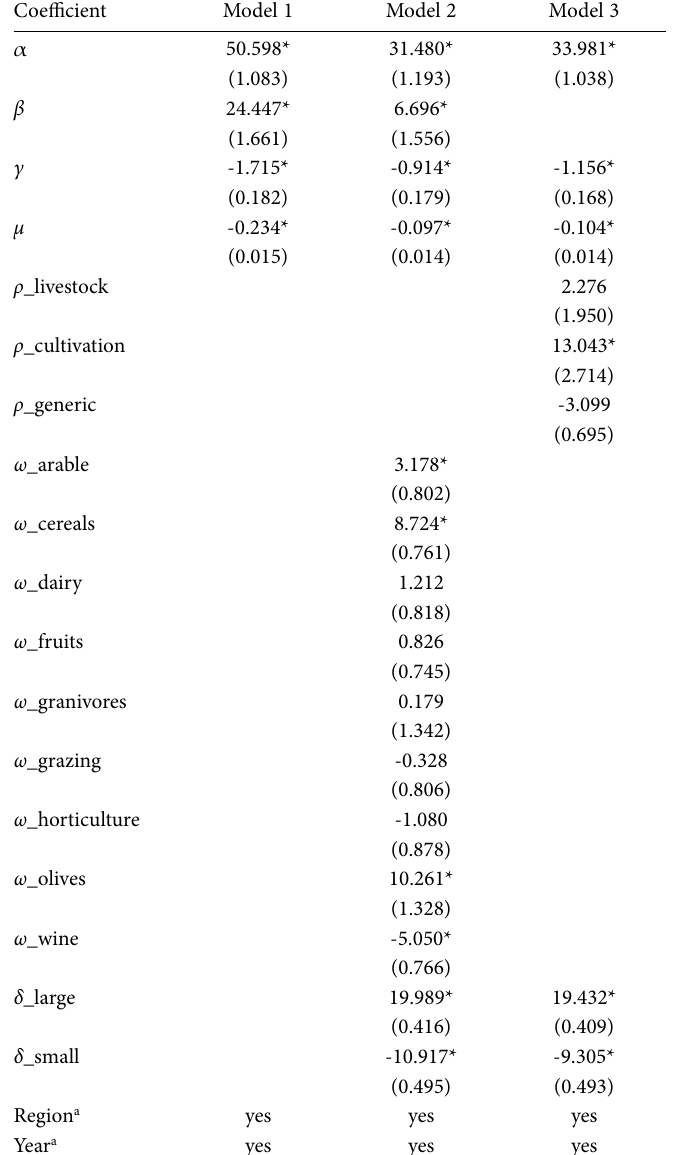
Table 7. OLS estimation of Models 1 to 3 (standard error in